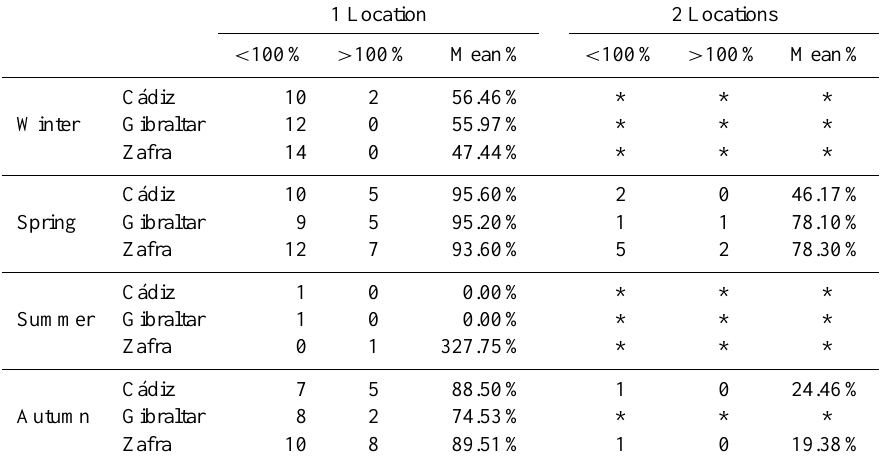
Table 3. Number of years when a rogation is celebrated when less ( < 100%) or more ( > 100%) precipitation than long term mean precipi- tation value is registered and precipitation mean anomaly in Cadiz, Gibraltar and Zafra for years with rogations celebrated simultaneously in 1 or 2 locations (Seville and Zafra). Anomalies are computed as percentages with respect to the average of the period 1805–1850 for C´adiz, 1790–1850 for Gibraltar and 1750–1840 for